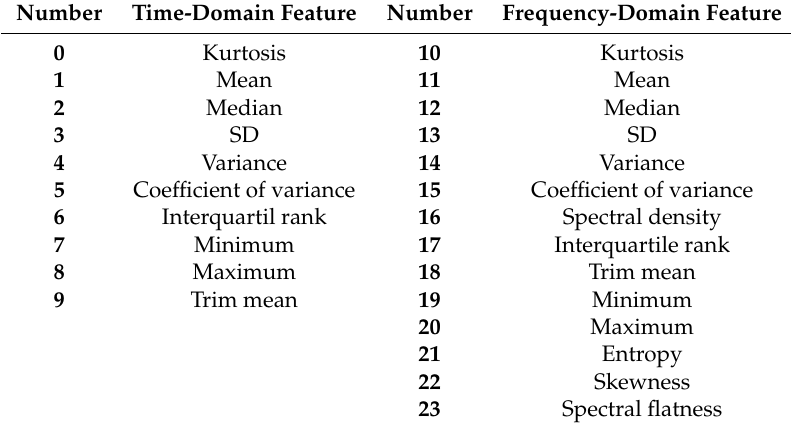
Table 3. Features extracted from the hourly motor activity